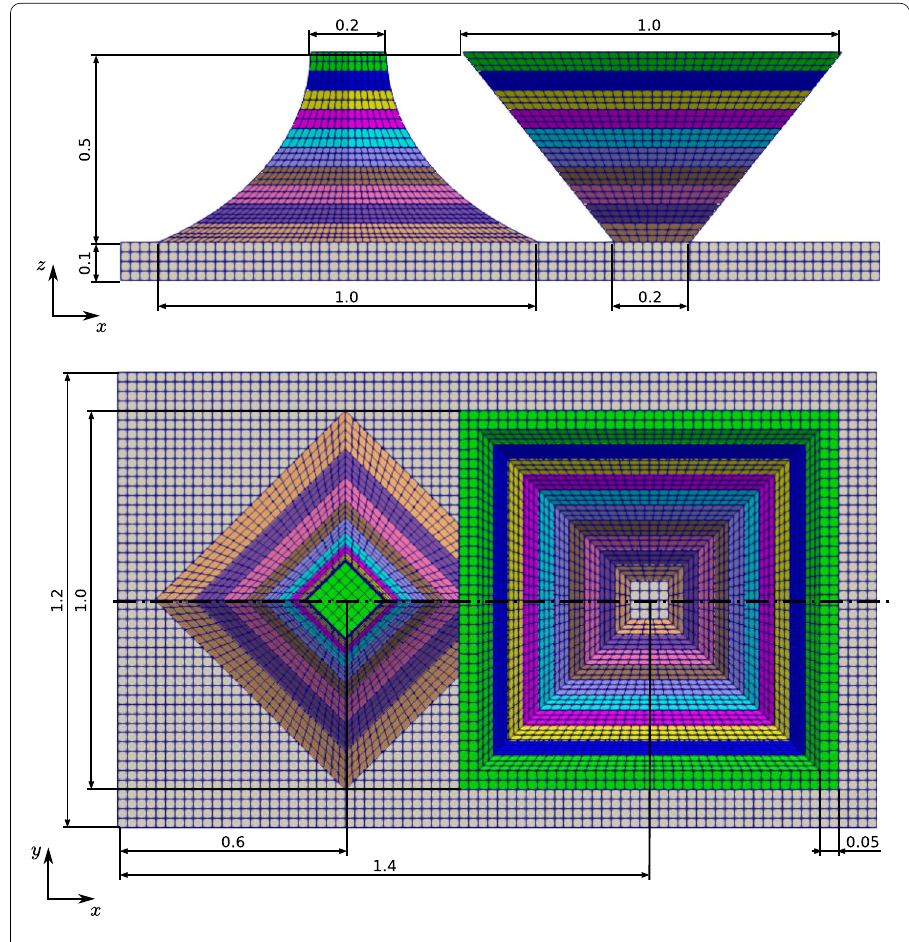
Fig. 23 Geometry of pyramids example. Dimensions in